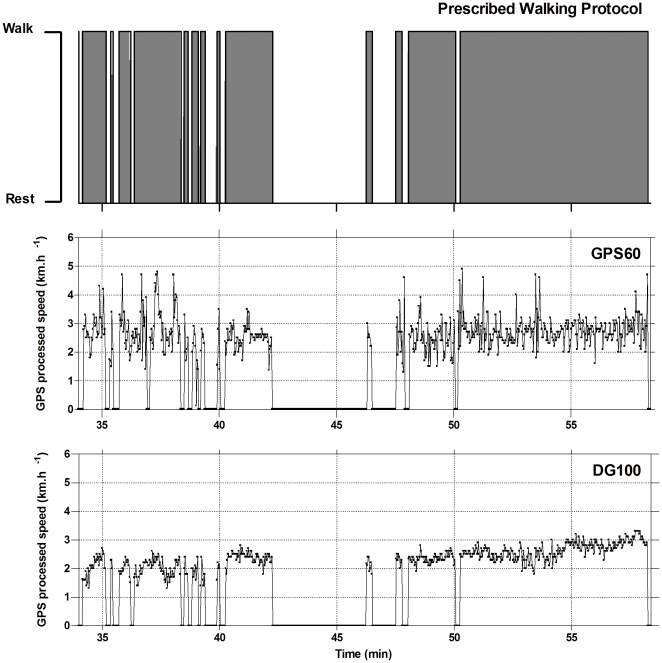
A typical example of GPS processed speed data obtained from a prescribed outdoor walking protocol, both for the DG100 and the GPS60.The entire PWP is not represented on the graph to simplify the figure. The period represented on the graph lasts ∼24 min (from minute 34.2 to minute 58.3).